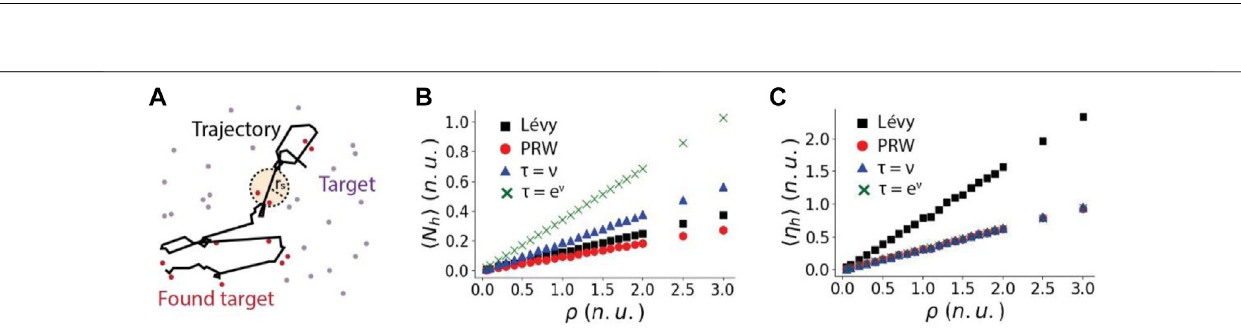
FIGURE 4 | Particle motility in fl uenced by the moving strategies in a homogeneous environment. (A) , Distributions of persistent length ( v τ ) of PRW, Lévy walk, linear RWSP ( τ (cid:2) v ) and nonlinear RWSP ( τ (cid:2) e v ) , whose tails can be well-approximated by a power law. (B) , Mean square displacements (MSDs) over time. (C) , Particle distributions at t (cid:2) 32 s . Dots represent the particle distributions. Solid lines represent Gaussian distributions. (D) , Example trajectories. (E) Jensen Shannon divergence (JSD) over time, which indicates the difference between the particle distribution and a Gaussian